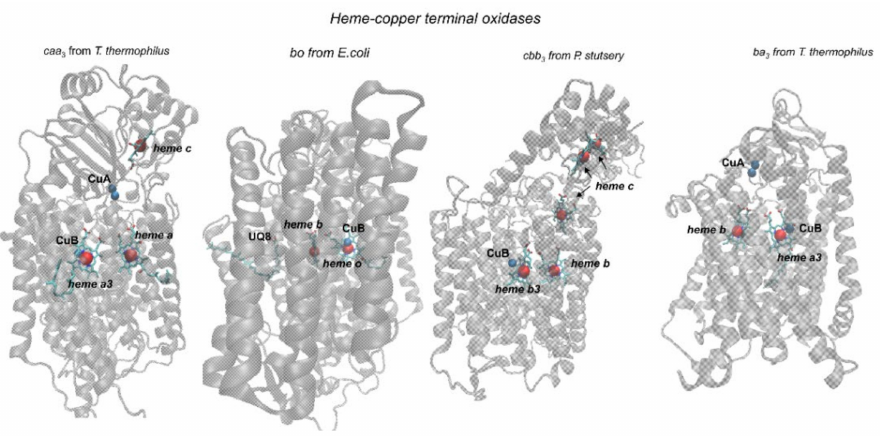
families: caa 3 from T. thermophilus ([28], PDB ID: 2YEV, A2 family), bo from E. coli ([29], PDB ID: 6WTI, A family), cbb 3 from P. stutzeri ([30], PDB ID: 5DJQ, C family) and ba 3 from T. thermophilus ([31], PDB ID: 5NDC, B family). The figure was carried out using Visual Molecular Dynamics software (v1.9.3)